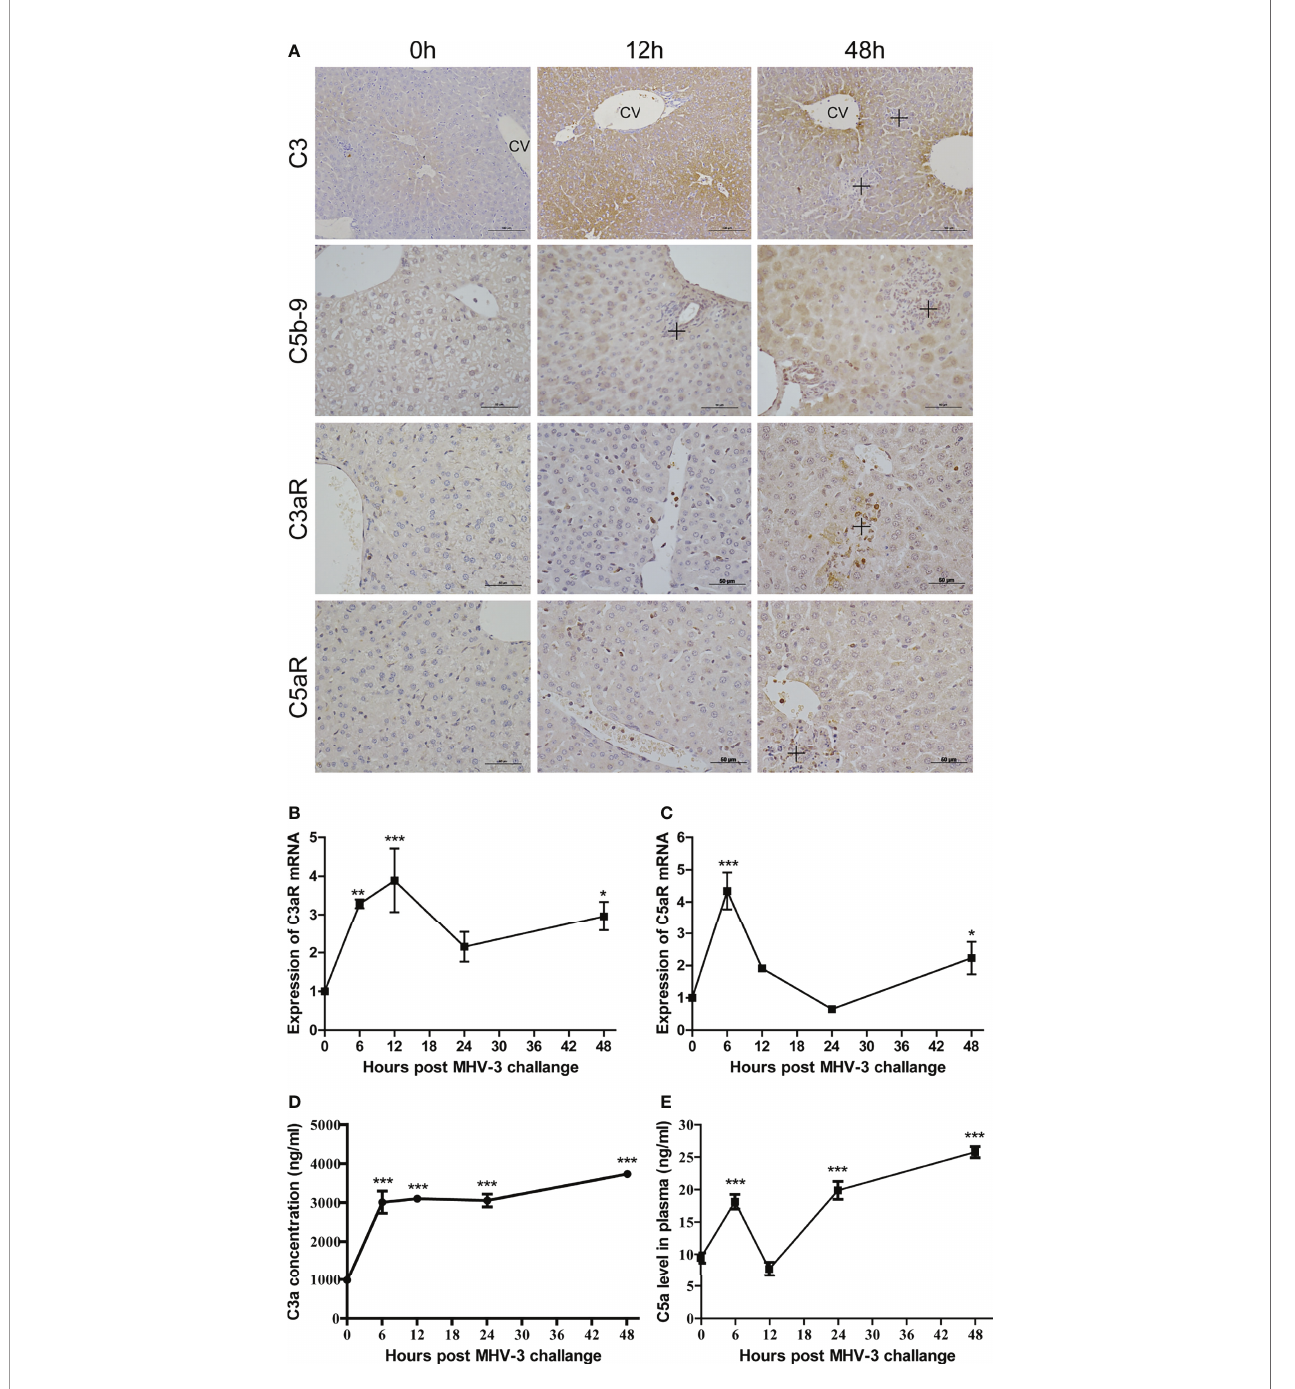
FIGURE 1 | Involvement of complement after MHV-3 infection. WT mice were euthanized 0, 6, 12, 24, and 48 hrs after MHV-3 challenge. (A) Immunohistochemical staining for the deposition of C3, C5b-9, and for the expression of C3aR and C5aR in liver tissue samples (CV, central vein; cross, in fl ammatory in fi ltrates or necrotic areas). (B, C) Levels of C3aR mRNA and C5aR mRNA, as determined by relative quantitative real-time RT-qPCR in liver tissues at the indicated times. (D, E) Serum concentrations of C3a and C5a at the indicated times. These results are representative of three independent experiments with similar results (n = 4 – 5 per group). * p <0.05, ** p <0.01, *** p <0.001 compared with 0 time. C3 original magni fi cation, ×200; C5b-9, C3aR, and C5aR original magni fi cation,